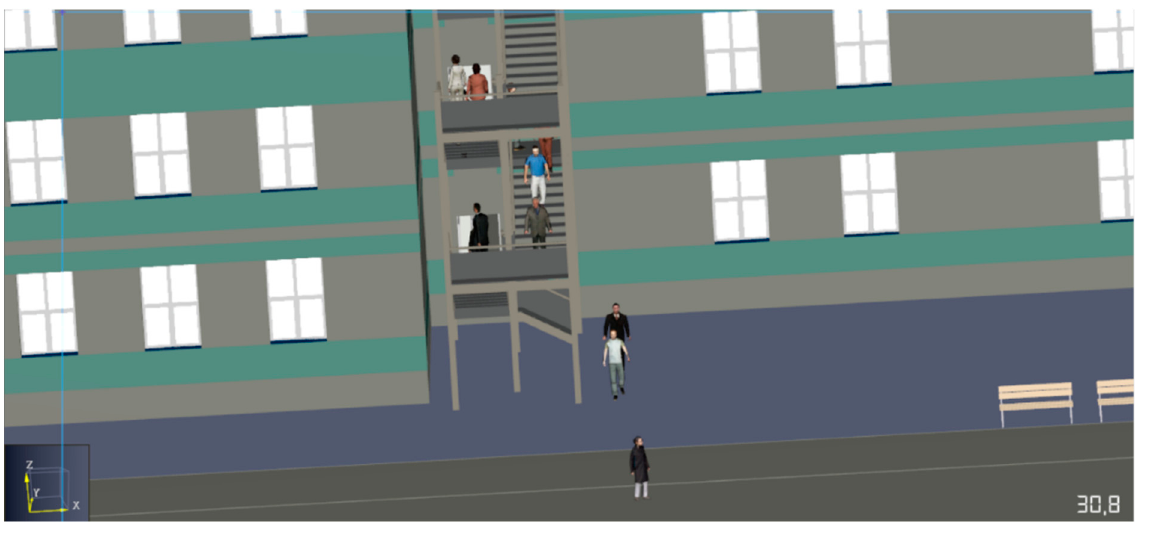
Figure 11. Evacuation process.